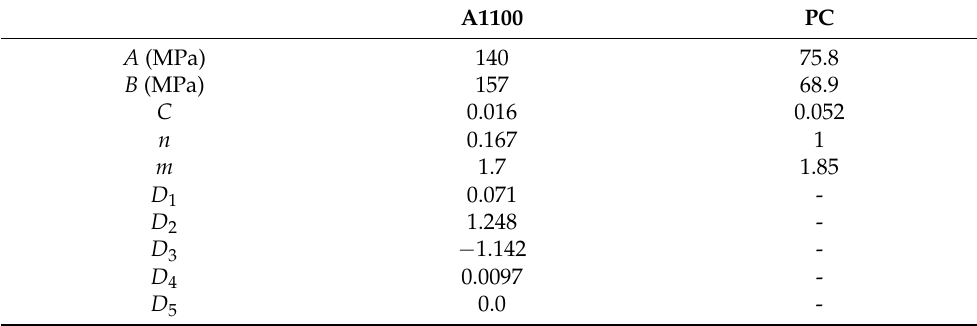
Table 3. Johnson–Cook strength and failure models parameters for A1100 [8,22] and PC [8]. A1100 PC A (MPa) 140 75.8 B (MPa) 157 68.9 C 0.016 0.052